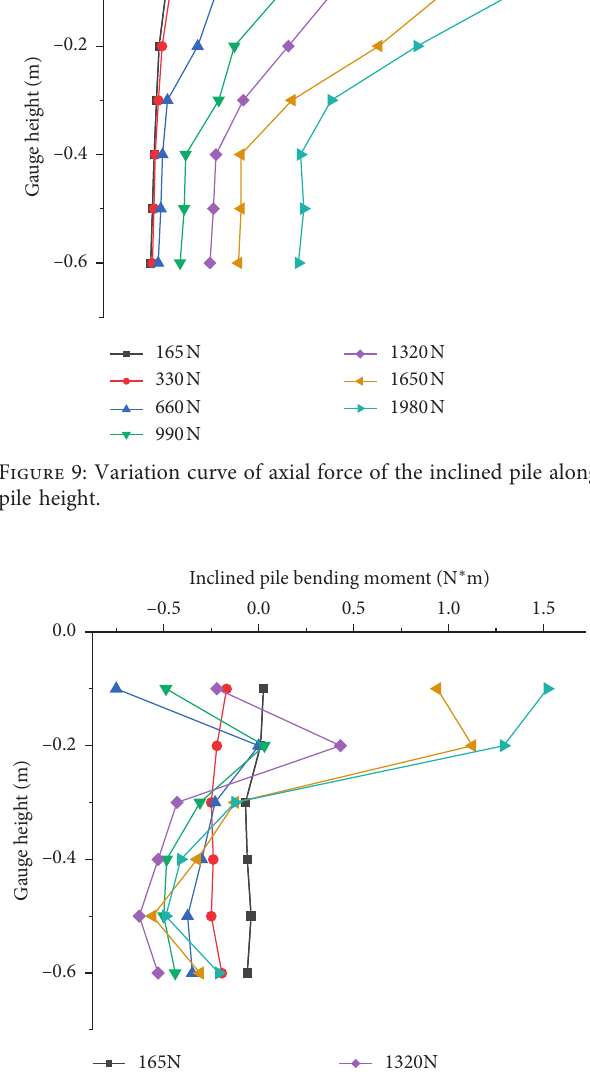
Figure 8: Variation curve of axial force of straight pile along pile height.